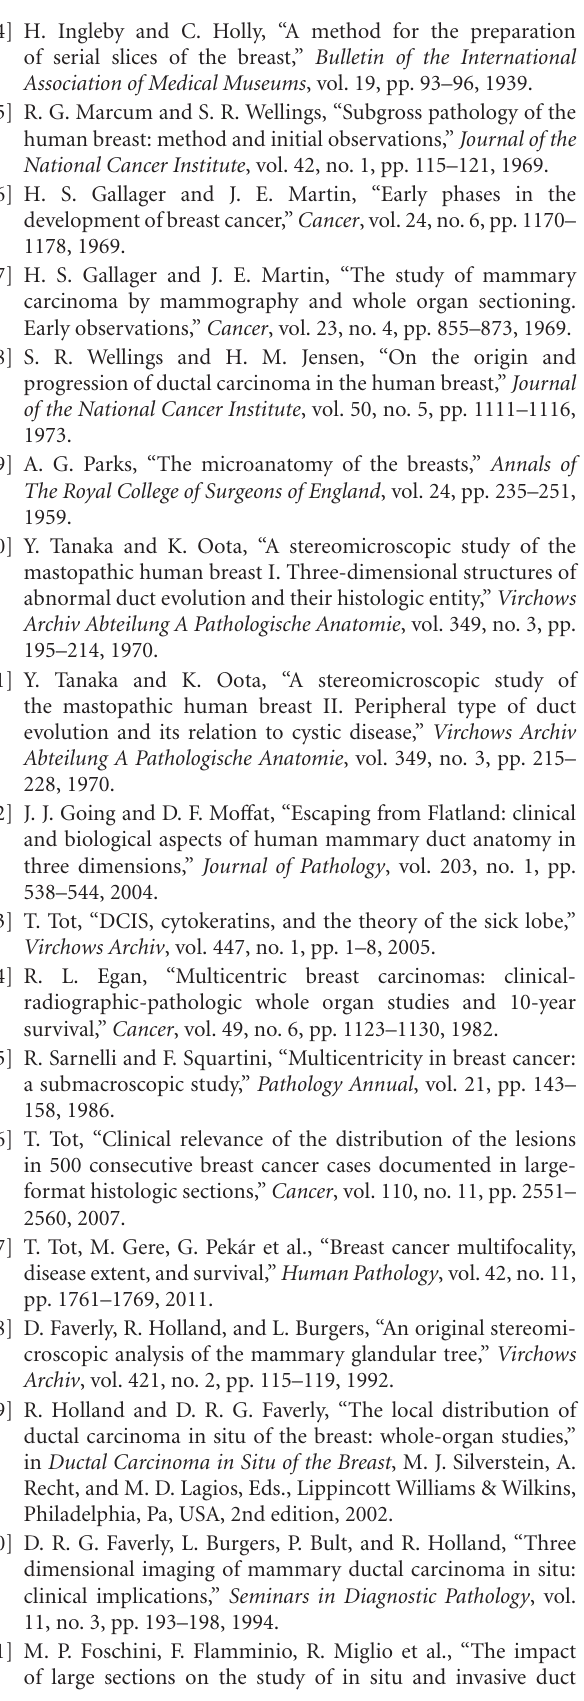
every day practice, especially in tumour pathology both for breast and most